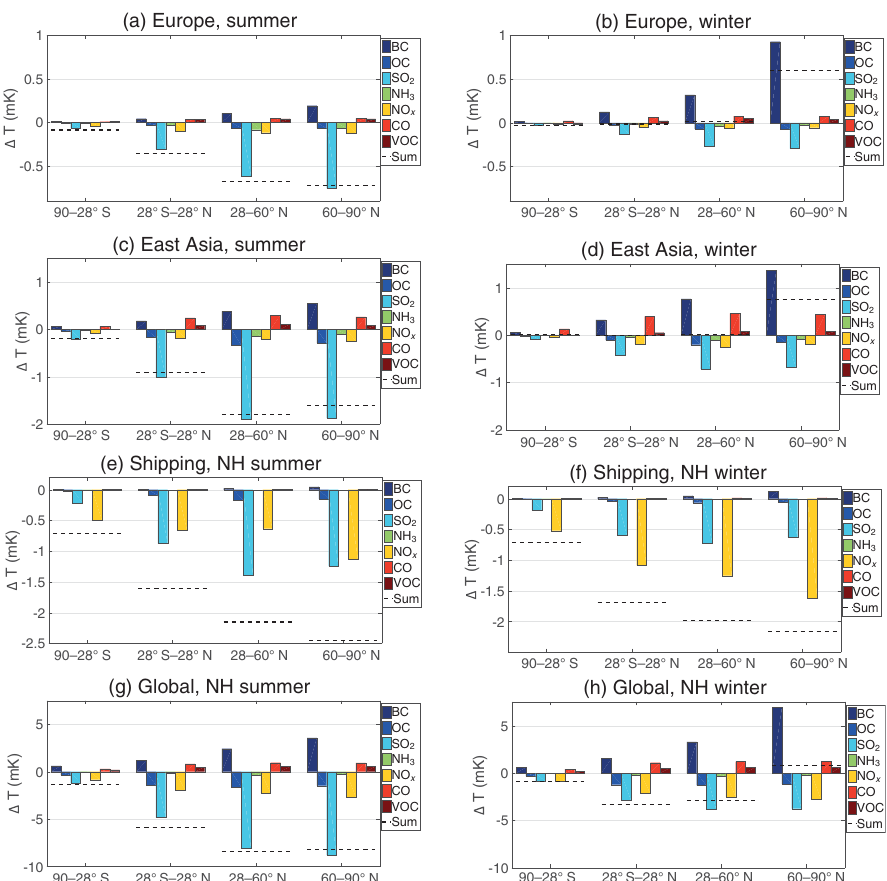
Figure 3. The regional temperature response for a time horizon of 20 years after regional and seasonal emissions in 2008 based on ARTP(20). The four latitude response bands represent the SH middle–high latitudes, tropics, NH midlatitudes, and Arctic. The global response average is given in Fig. S2. From top to bottom, the emission regions are Europe, East Asia, the global shipping sector, and the globe. The emissions are split into NH summer season (May–October) to the left and NH winter season (November–April) to the right. Note that the y axis differs for the regions. The horizontal dashed lines show the sum for each response